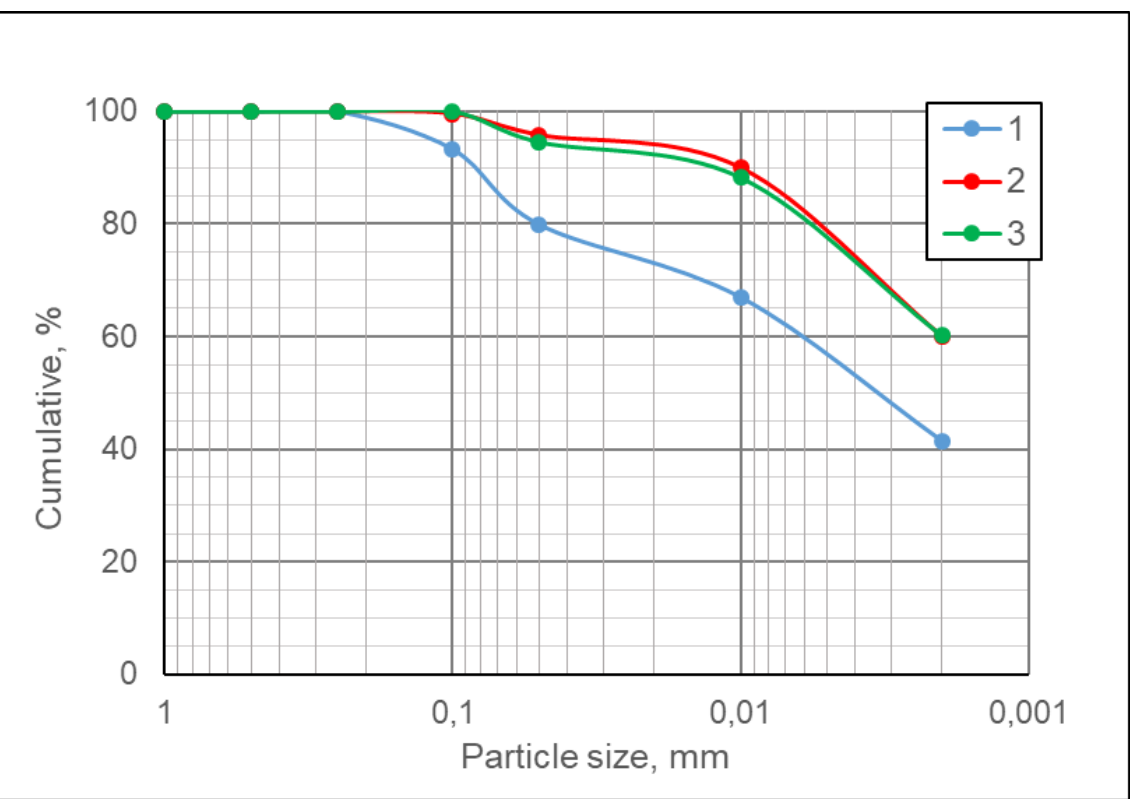
Figure 6. Particle size distribution of investigated soils.